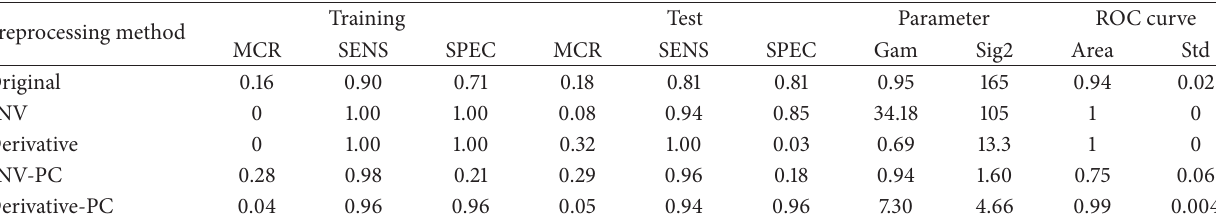
Table 1: Summarization of model performance of different classification